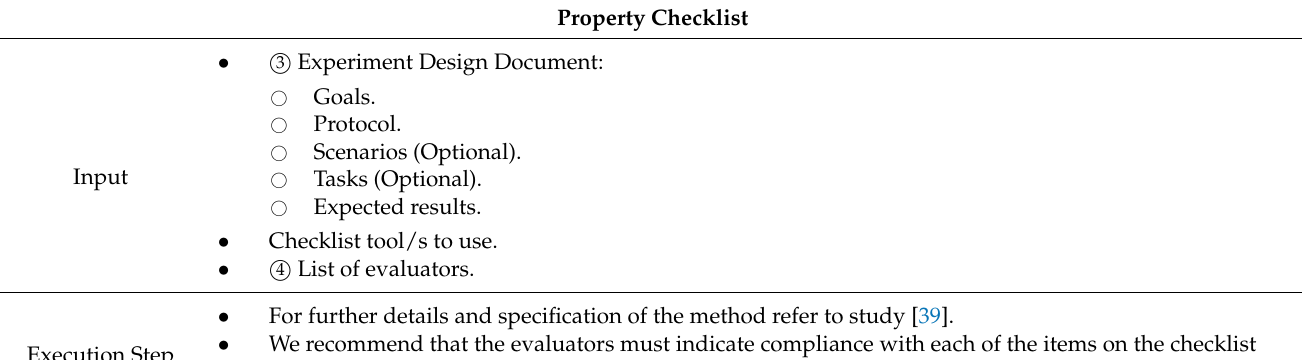
Table A8. Property Checklist Specification.